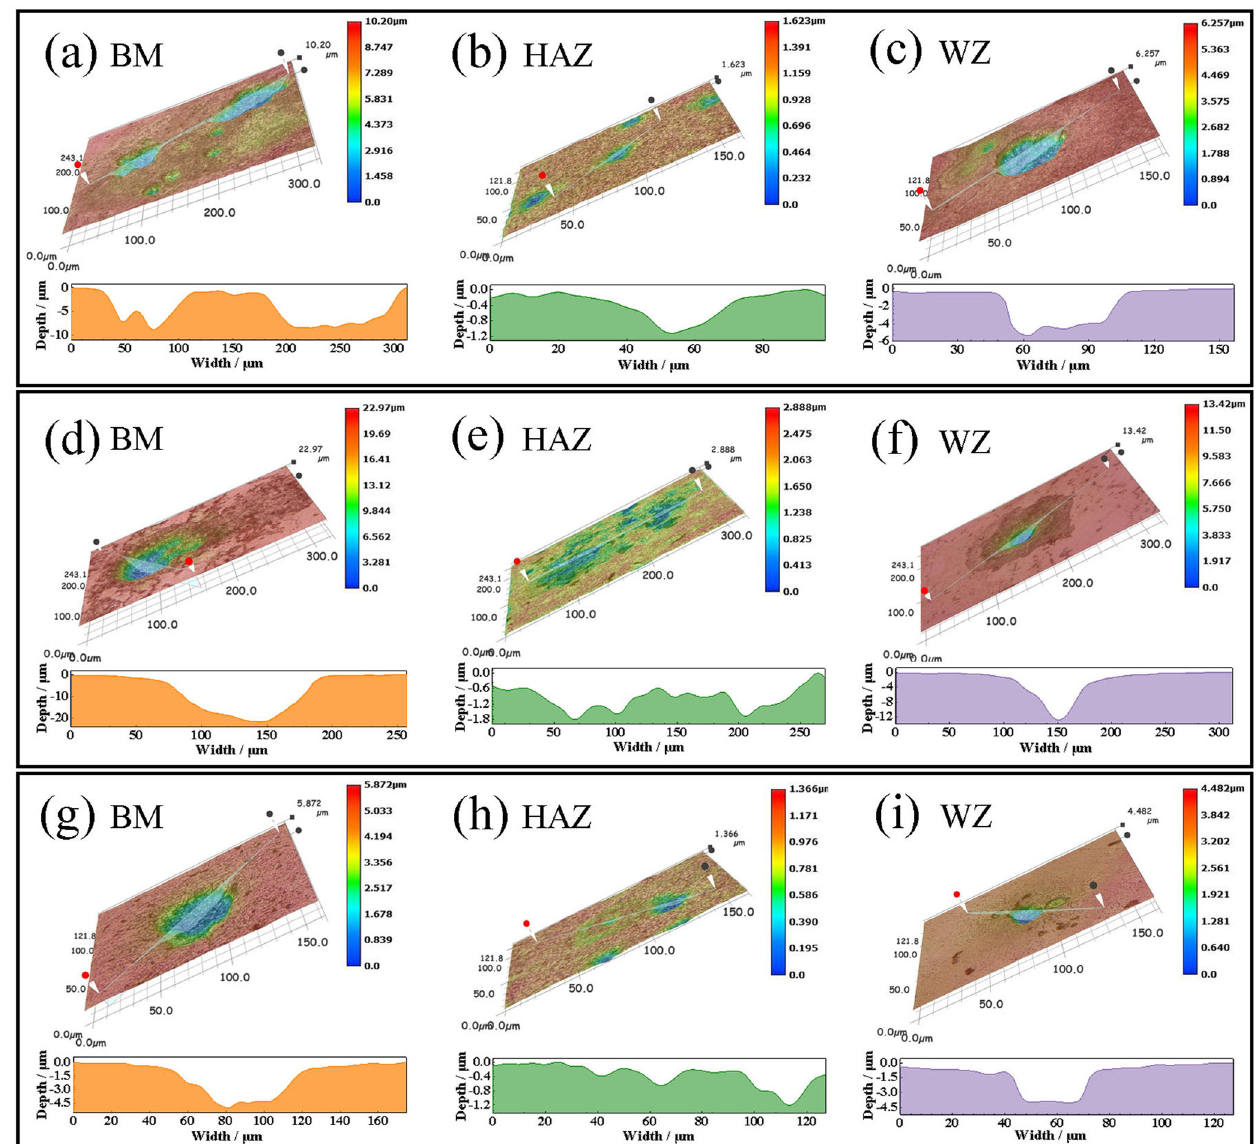
Fig. 6 3D ultra-depth micro-morphology of the welded joints after 30 d immersion. a – c Show the 3D ultra-depth micro-morphology of BM, HAZ, and WZ zones after 30 d immersion in the medium with 0% organic carbon sources level. d – f Show the 3D ultra-depth micro- morphology of BM, HAZ, and WZ zones after 30 d immersion in the medium with 1% organic carbon sources level. g – i Show the3D ultra- depth micro-morphology of BM, HAZ and WZ zones after 30 d immersion in the medium with 100% organic carbon sources